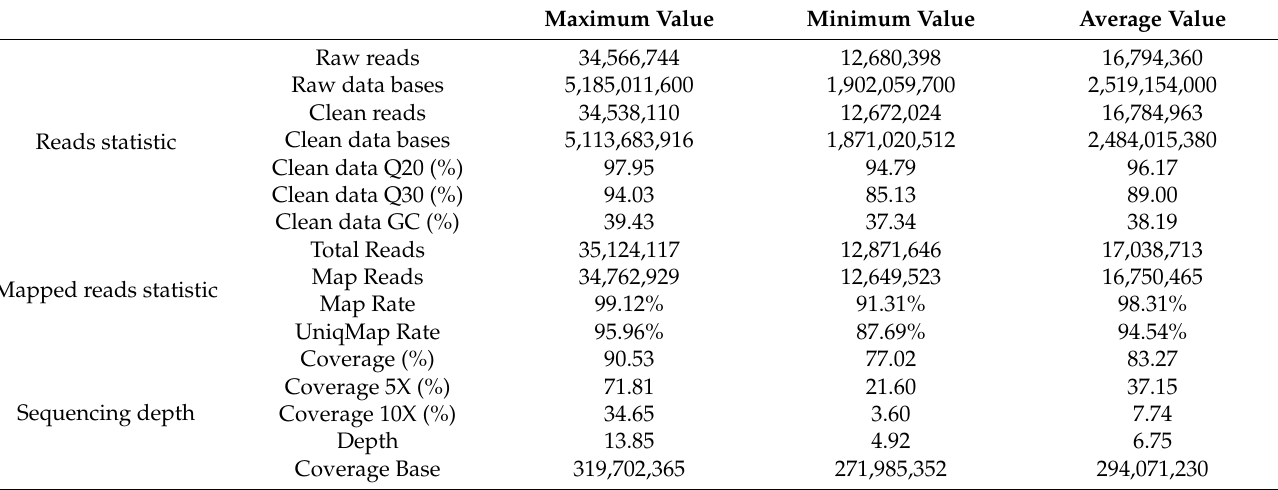
Table 1. Statistics and quality assessment of sequence